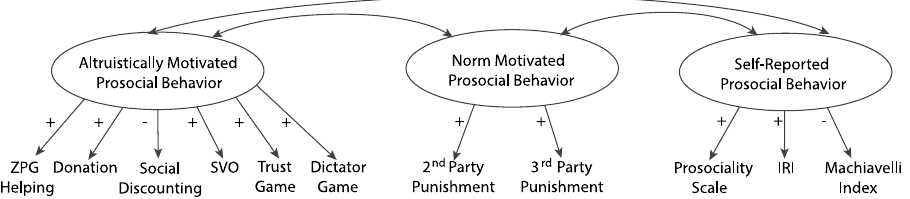
Figure 1. Structure of human prosociality. The figure schematically illustrates the proposed relationship of various prosocial measures and three latent variables of prosociality 34,35 . ZPG: Zurich Prosocial Game, SVO: Social Value Orientation, IRI: Interpersonal Reactivity Index. + / − indicate positive/negative standardized regression weights. Note that the variables 2 nd and 3 rd Party Punishment were constrained to equality. Note that the variable Social Discounting was modelled to also load on the factor Self-Reported Prosocial Behaviour in 35 . This relation was added in a data-driven manner (indicated by model modification indices) and is not depicted here, nor was it modelled in the analyses of the present